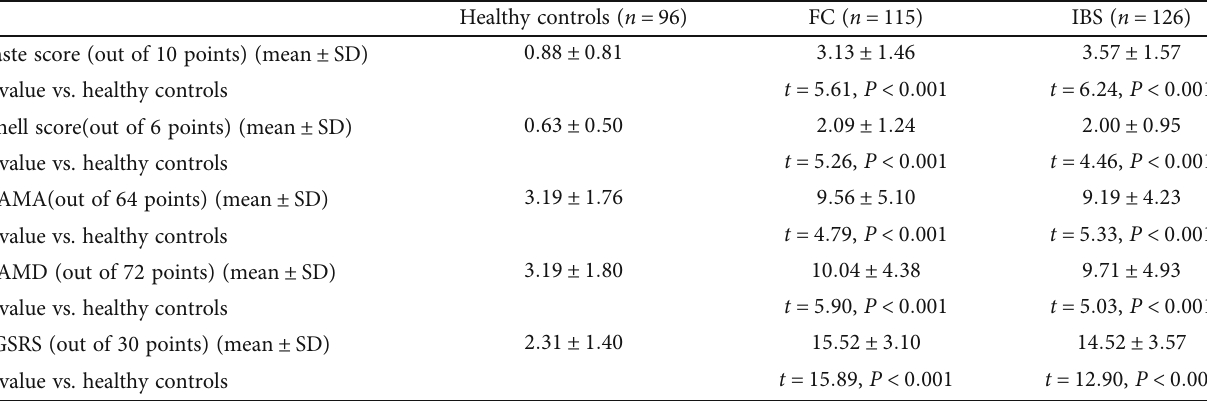
Table 2: Taste, smell, HAMA, and HAMD scores and lower gastrointestinal symptoms rating score in the 3 study groups (healthy controls, functional constipation, and irritable bowel